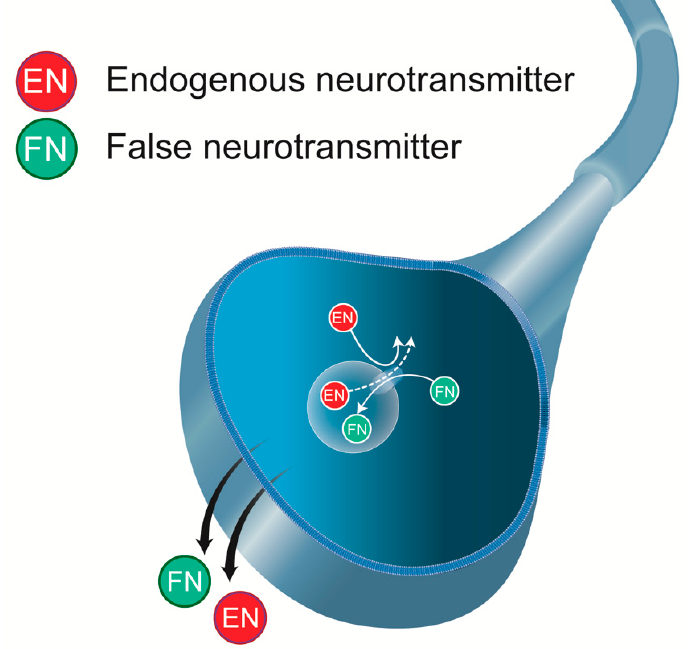
Figure 1. False neurotransmitter (FN). This ectopic compound, considered “unwanted,” enters a neuron or is directly formed in the neuron. The FN will replace the endogenous neurotransmitter (EN) in synaptic storage vesicles and can be released in response to a depolarizing stimulus.